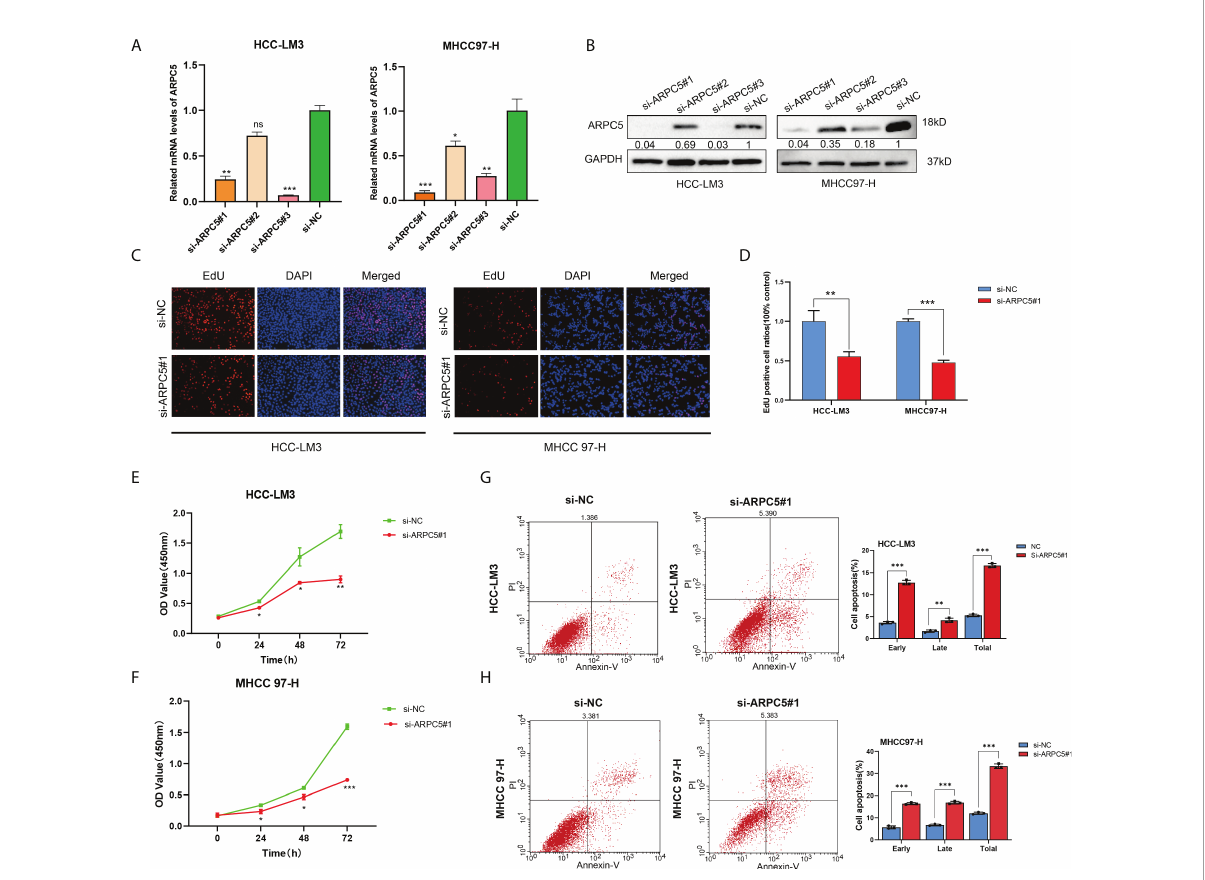
FIGURE 11 Silencing of ARPC5 inhibits cell proliferation and promotes cell apoptosis of HCC. (A) The knockdown ef fi ciency of siRNA – ARPC5 was examined in HCC-LM3 and MHCC97-H cells with qPCR. (B) The knockdown ef fi ciency of siRNA-ARPC5 was examined in HCC-LM3 and MHCC97-H cells with Western blot. The number presented as relative protein expression levels of ARPC5. ( C – D ) EdU assays for HCC-LM3 and MHCC 97-H were performed to evaluate cell proliferation ability after transfecting siRNA-ARPC5#1. Representative images (C) and the number of proliferative cells were calculated (D) ; original magni fi cation, ×200. (E – F) Cellular growth curves were evaluated by CCK-8 assays in HCC-LM3 and MHCC97-H cells. (G – H) Flow cytometry was applied to test the apoptosis of HCC cells transfected with si-ARPC5 #1 in HCC-LM3 and MHCC 97-H cells. All data are presented as the M ± SD of three independent experiments. * p < 0.05; ** p < 0.01; *** p < 0.001. ns, no signi fi